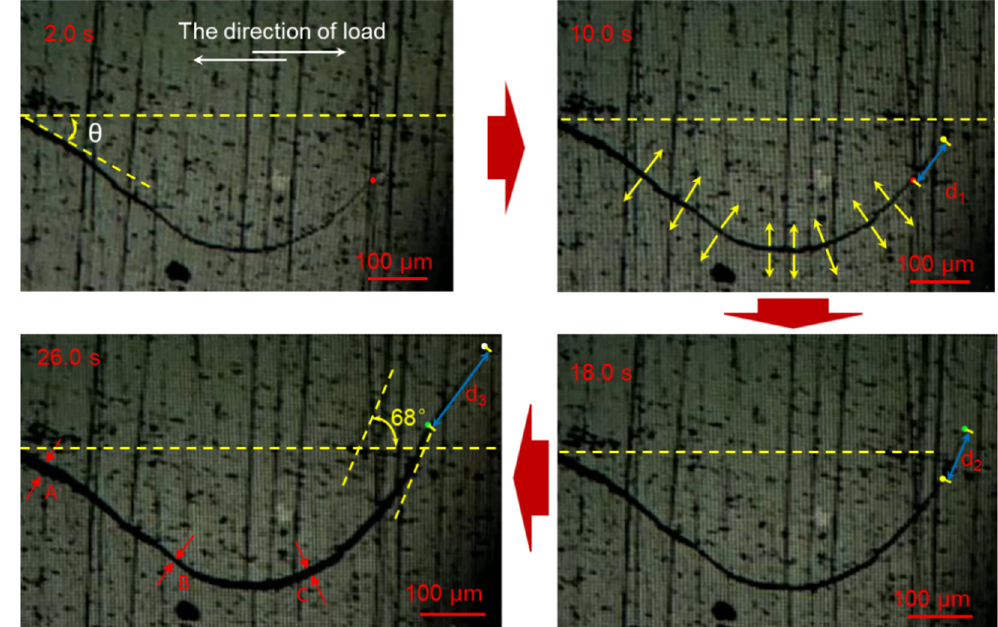
Figure 5. Microcrack propagation at different times. A, B and C—Positions of different microcrack widths. d 1 —Length of the crack propagation on the coal sample surface in 2.0 s~10.0 s; d 2 —Length of the crack propagation in 10.0 s~18.0 s; d 3 —Length of the crack propagation in 18.0 s~26.0 s.